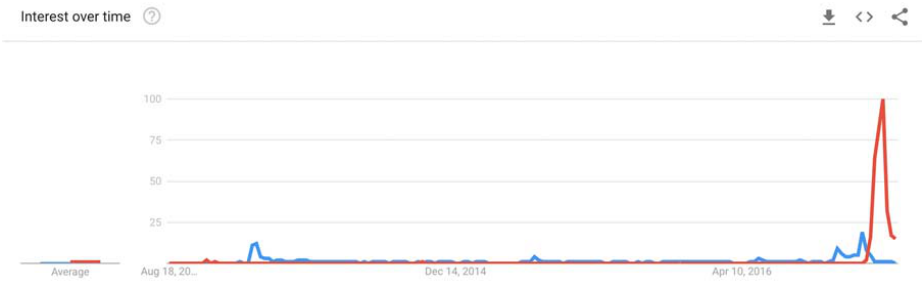
Figure 1. Search trends for “Bridgegate” (blue) and “Pizzagate” (red) for a 4 ‐ year period, beginning in August 2013 (prior to the events of Bridgegate), as modeled on GoogleTrends. The lines of the graph cross during the week of the presidential election in 2016.